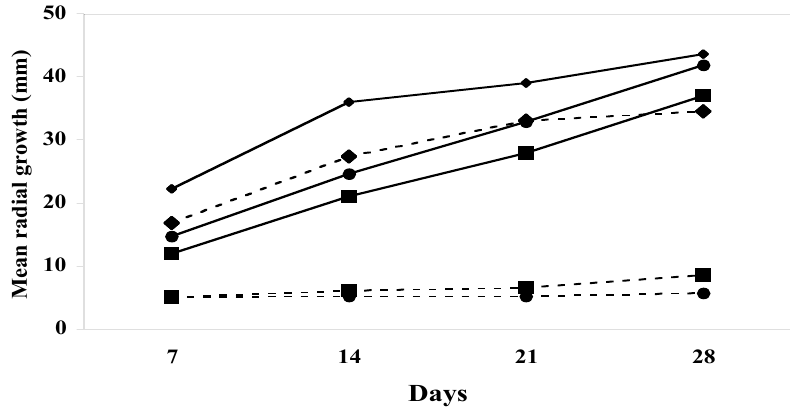
Fig. 2. Radial growth of Phaeomoniella chlamydospora ( Pch ) strains 24 ( (cid:2) ) and 16 ( (cid:4) ), and of Phaeoacremonium rubrigenum strain 125 ( (cid:1) ) on Medium 1 (sodium salt of polygalacturonic acid, continuous line) and on Medium 2 (pectin, discontinuous line). Mean results of 8 plates ( SE < ± 1.2 mm ).